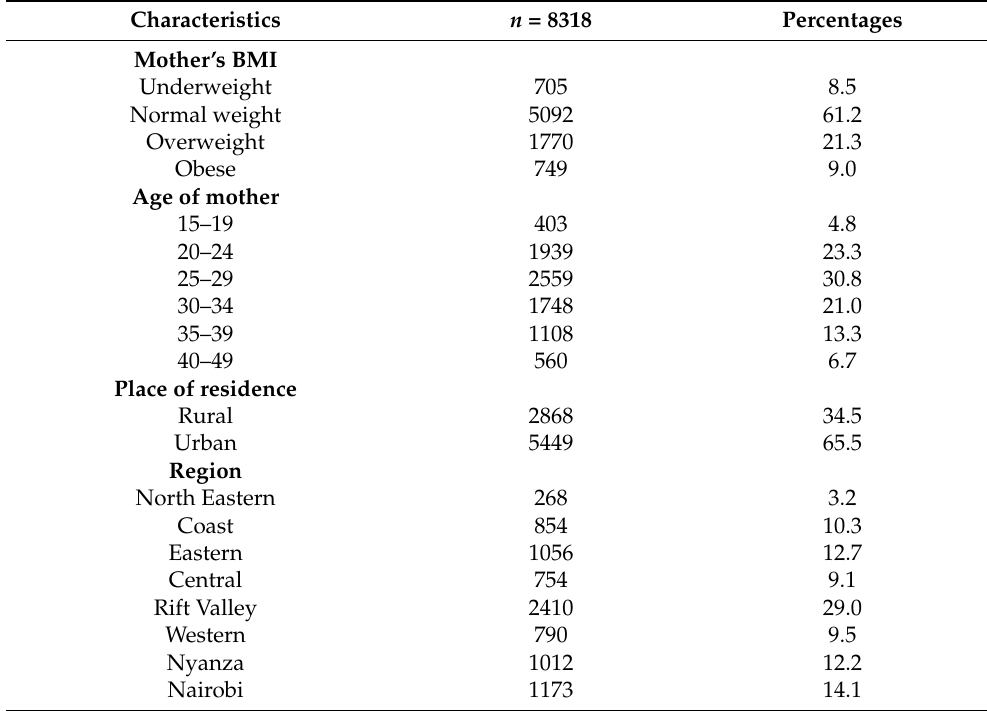
Table 1. Demographic characteristics of mother and child-related factors of the studied